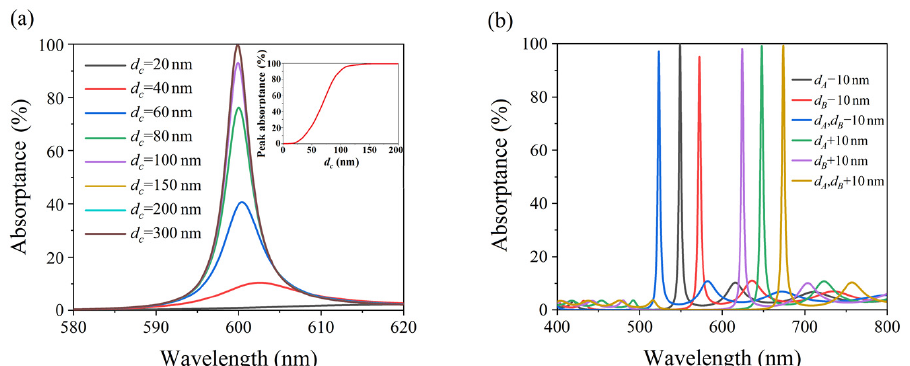
Figure 5. ( a ) Simulated absorption spectra of (BA) 8 MS with different metal layer M thicknesses (d M = 20 nm, 40 nm, 60 nm, 80 nm, 100 nm, 150 nm, 200 nm, 300 nm). The inset figure shows the absorptance of the absorption peak versus the thickness of the metal layer M. ( b ) Simulated absorption spectra of (BA) 8 MS with different dielectric layer